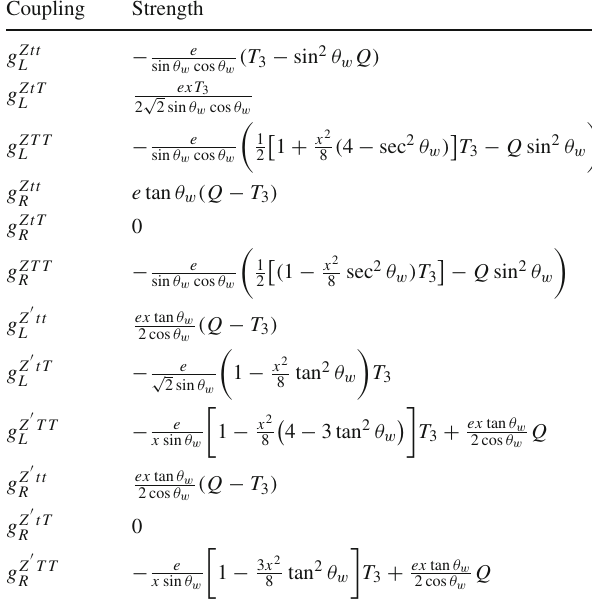
Table 6 Four point gauge couplings in the model – these have been evaluated perturbatively in x to O ( x 2 ) Vertex Strength